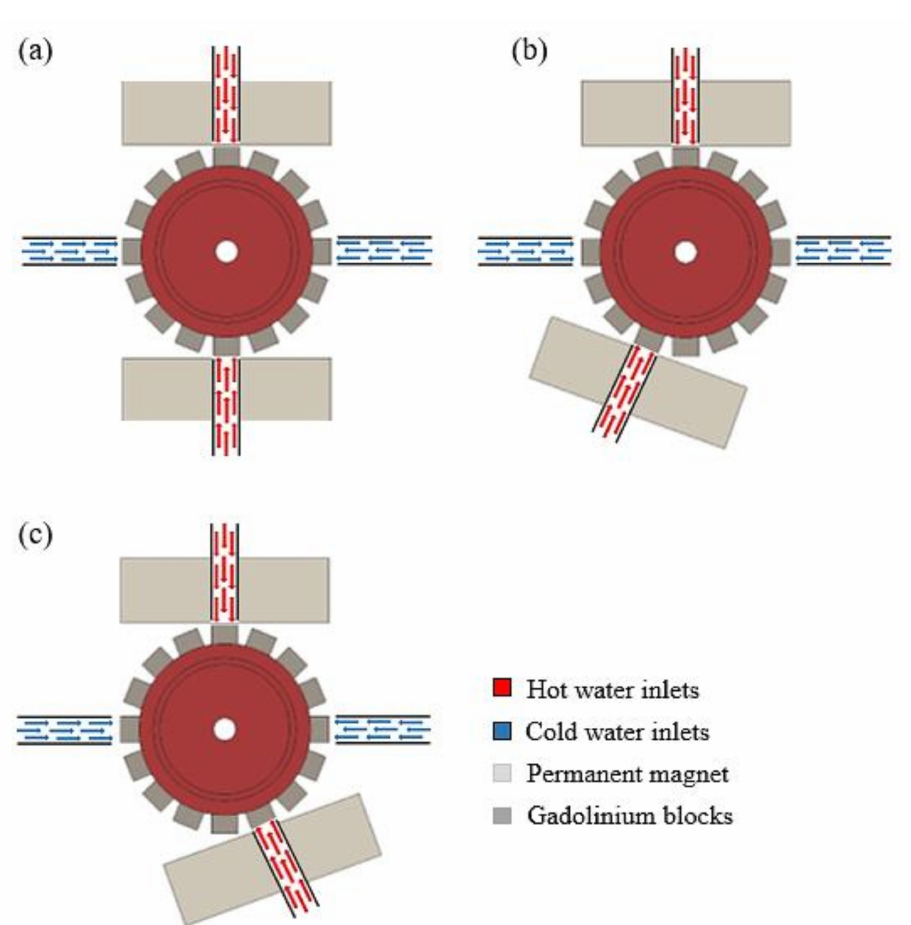
Figure 5. Simulated models of a thermomagnetic heat engine, where cold-water inlets are placed in the same position while the angle between the permanent magnet and hot-water inlets is varied: